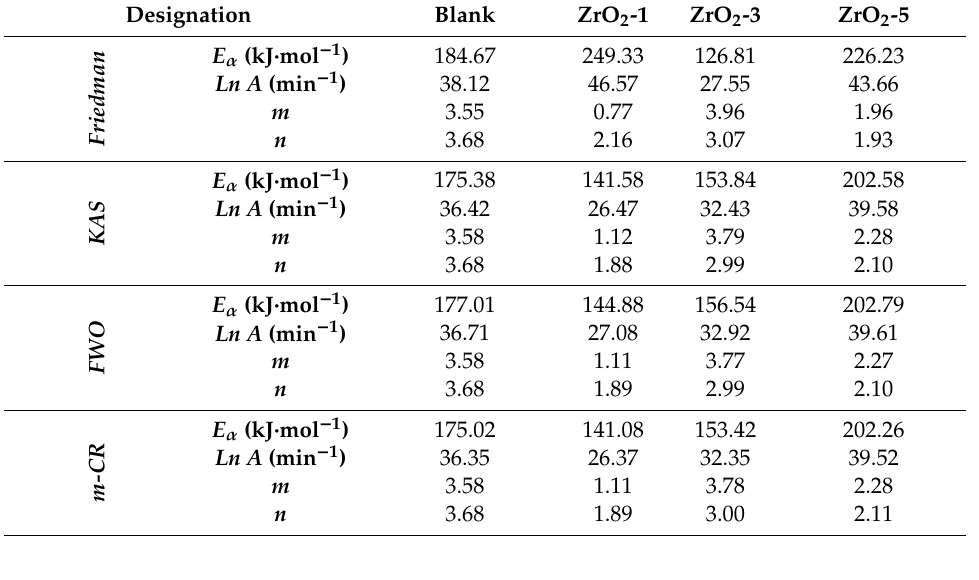
Table 3. Decomposition parameters based on the Sestak and Berggren decomposition reaction of PU nanocomposites calculated using di ff erent isoconversional kinetic models.